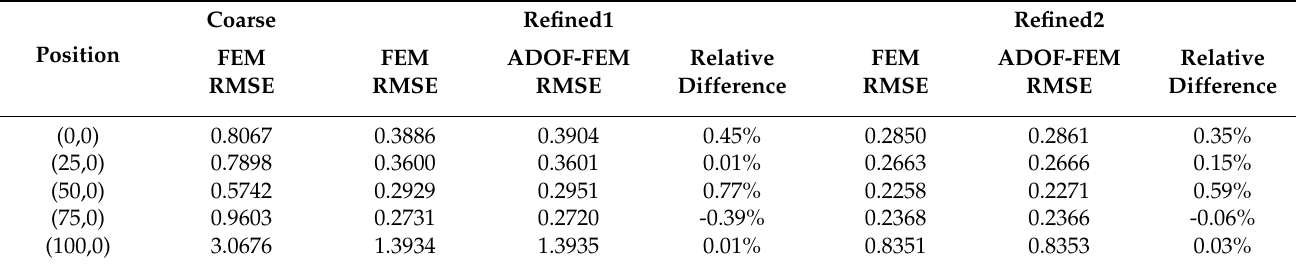
Figure 3. The change of the number of DOFs in Example 1. Table 2. The RMSE of the result of Example